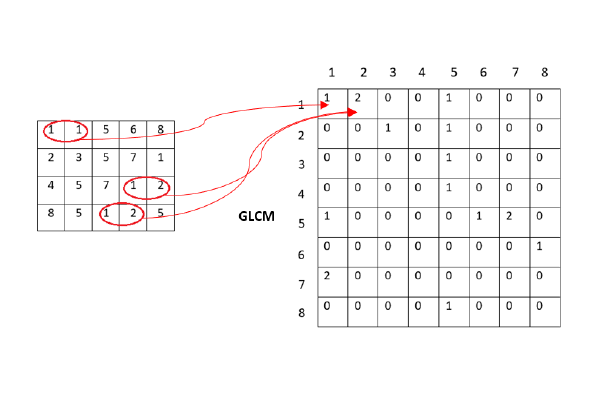
Figure 4. process used to create the GLCM